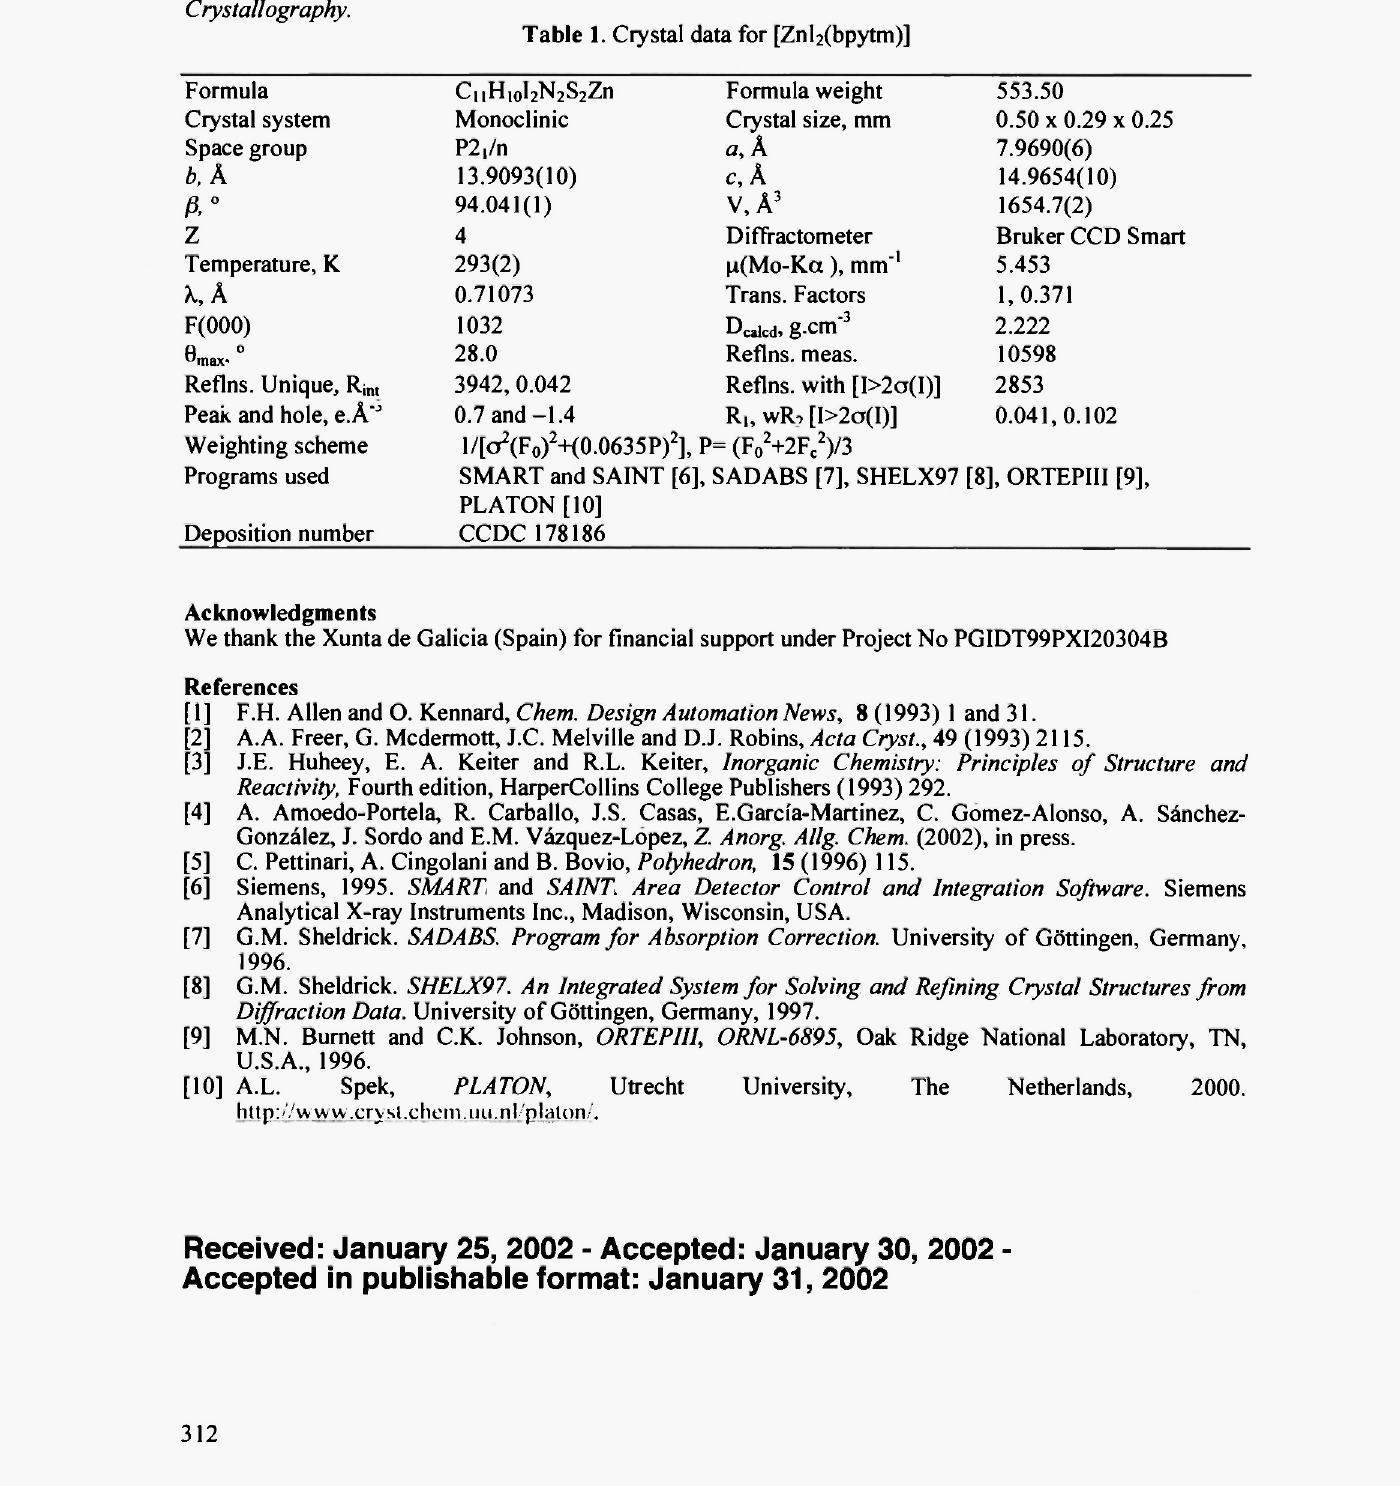
Table 1. Crystal data for [Znl 2